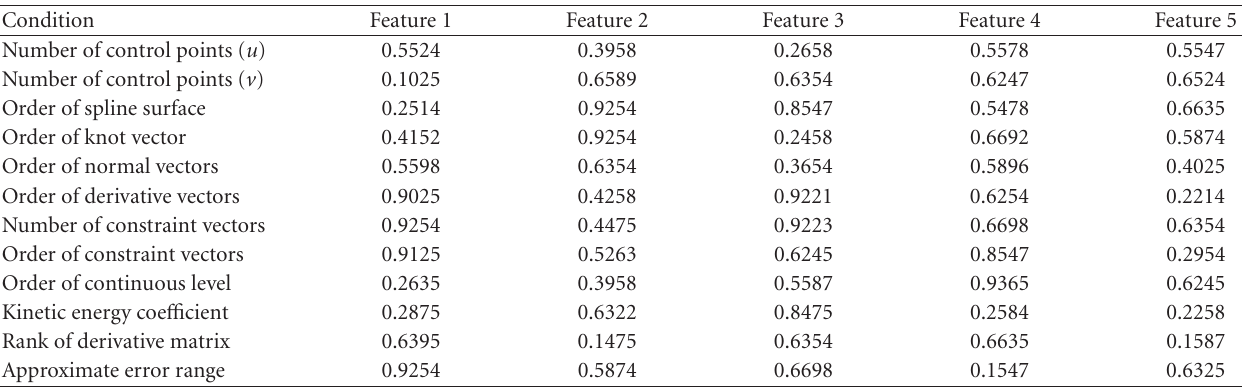
Table 10: Fuzzy relation degrees between experimental condition parameters and kinetic energy distribution surface features in B-spline surface of quasiuniform